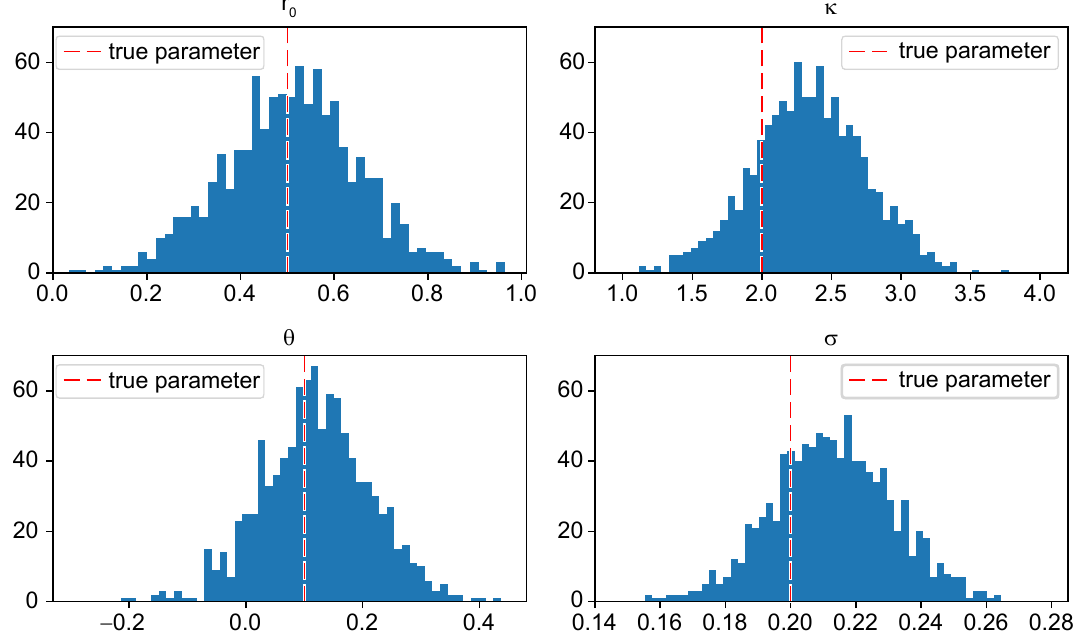
Figure 4. Histogram of the learned parameters obtained with the Adam optimizer. The learning rate is 0.05 and training is performed over 700 epochs. Total simulations: